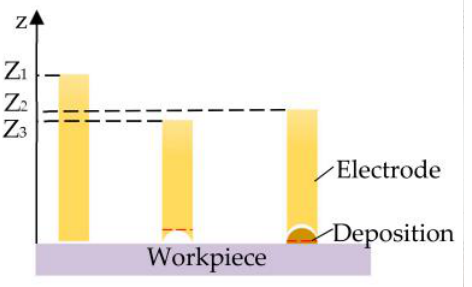
Figure 8. Measurement method of electrode loss by HV- µ EAM.